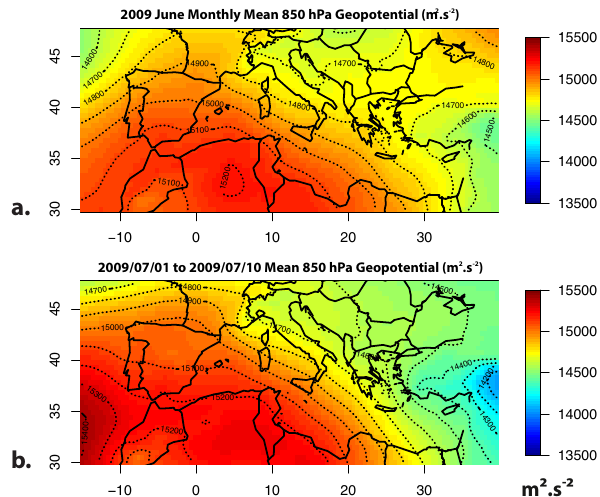
Figure 15. Mean 850hPa geopotential (m 2 s − 2 ) for (a) the June 2009 period and (b) the 1–10 July 2009 period. Data are taken from the 12h ERA-Interim